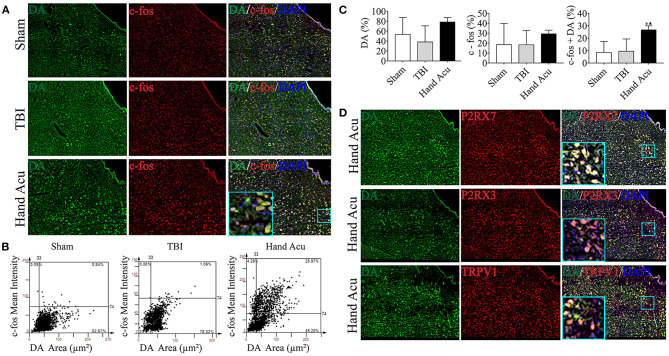
HTWP acupuncture activates dopaminergic neurons in the ventral periaqueductal gray. (A) Confocal and co-localization analyses of DA with c-fos and DAPI. (B,C) HistoFAXS tissue analysis of c-fos staining mean intensity vs. area (μm2), and quantitative analysis by image scanning of co-localization of c-fos with DA in the left vPAG of sham and TBI rats treated with or without HTWP acupuncture (hand Acu). (D) Confocal analyses and co-localization of P2RX7, P2RX3, TRPV1, and DA and in the left vPAG of sham and TBI rats treated with or without HTWP acupuncture (hand Acu, n = 3–4/group; one-way ANOVA). Error bars represent mean + SEM; ▴P < 0.05 vs. TBI; *P < 0.05 vs. Sham.